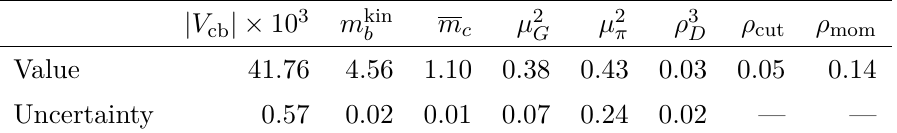
Table 5 . Results of our default fit using both Belle and Belle II data for | V cb | , m kin , and the correlation parameters ρ m c (2 GeV) , ρ 3 D All parameters are expressed in GeV at the appropriate power.